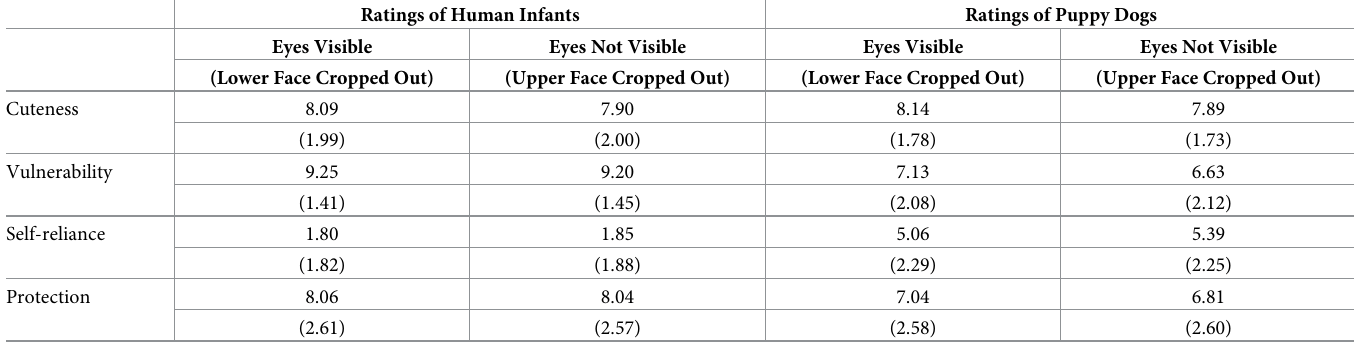
Table 2. Experiment 2: Mean ratings (with standard deviations in parentheses) of human infants and puppy dogs, as a function of whether their eyes were visible or not. Ratings of Human Infants Ratings of Puppy Dogs Eyes